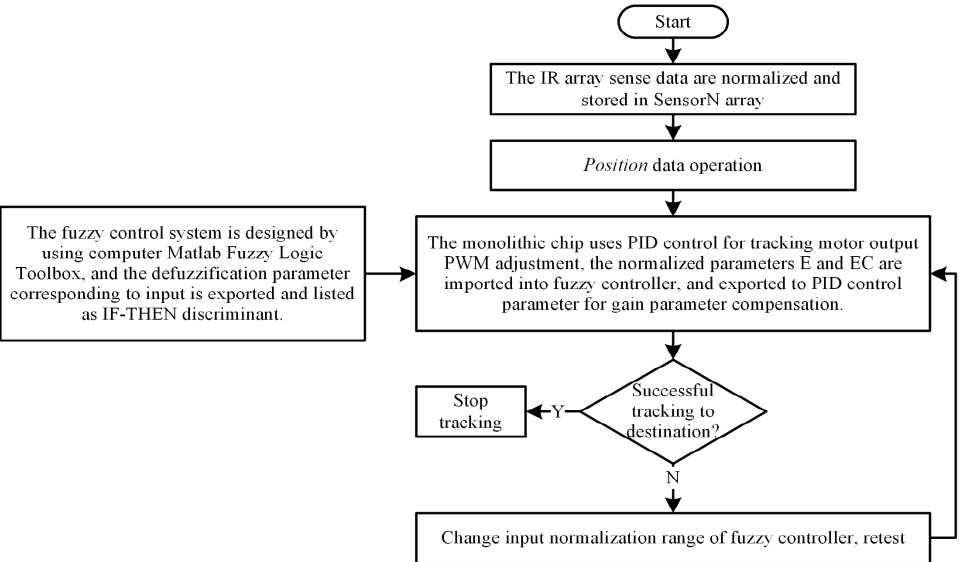
Figure 8. Experimental Process.